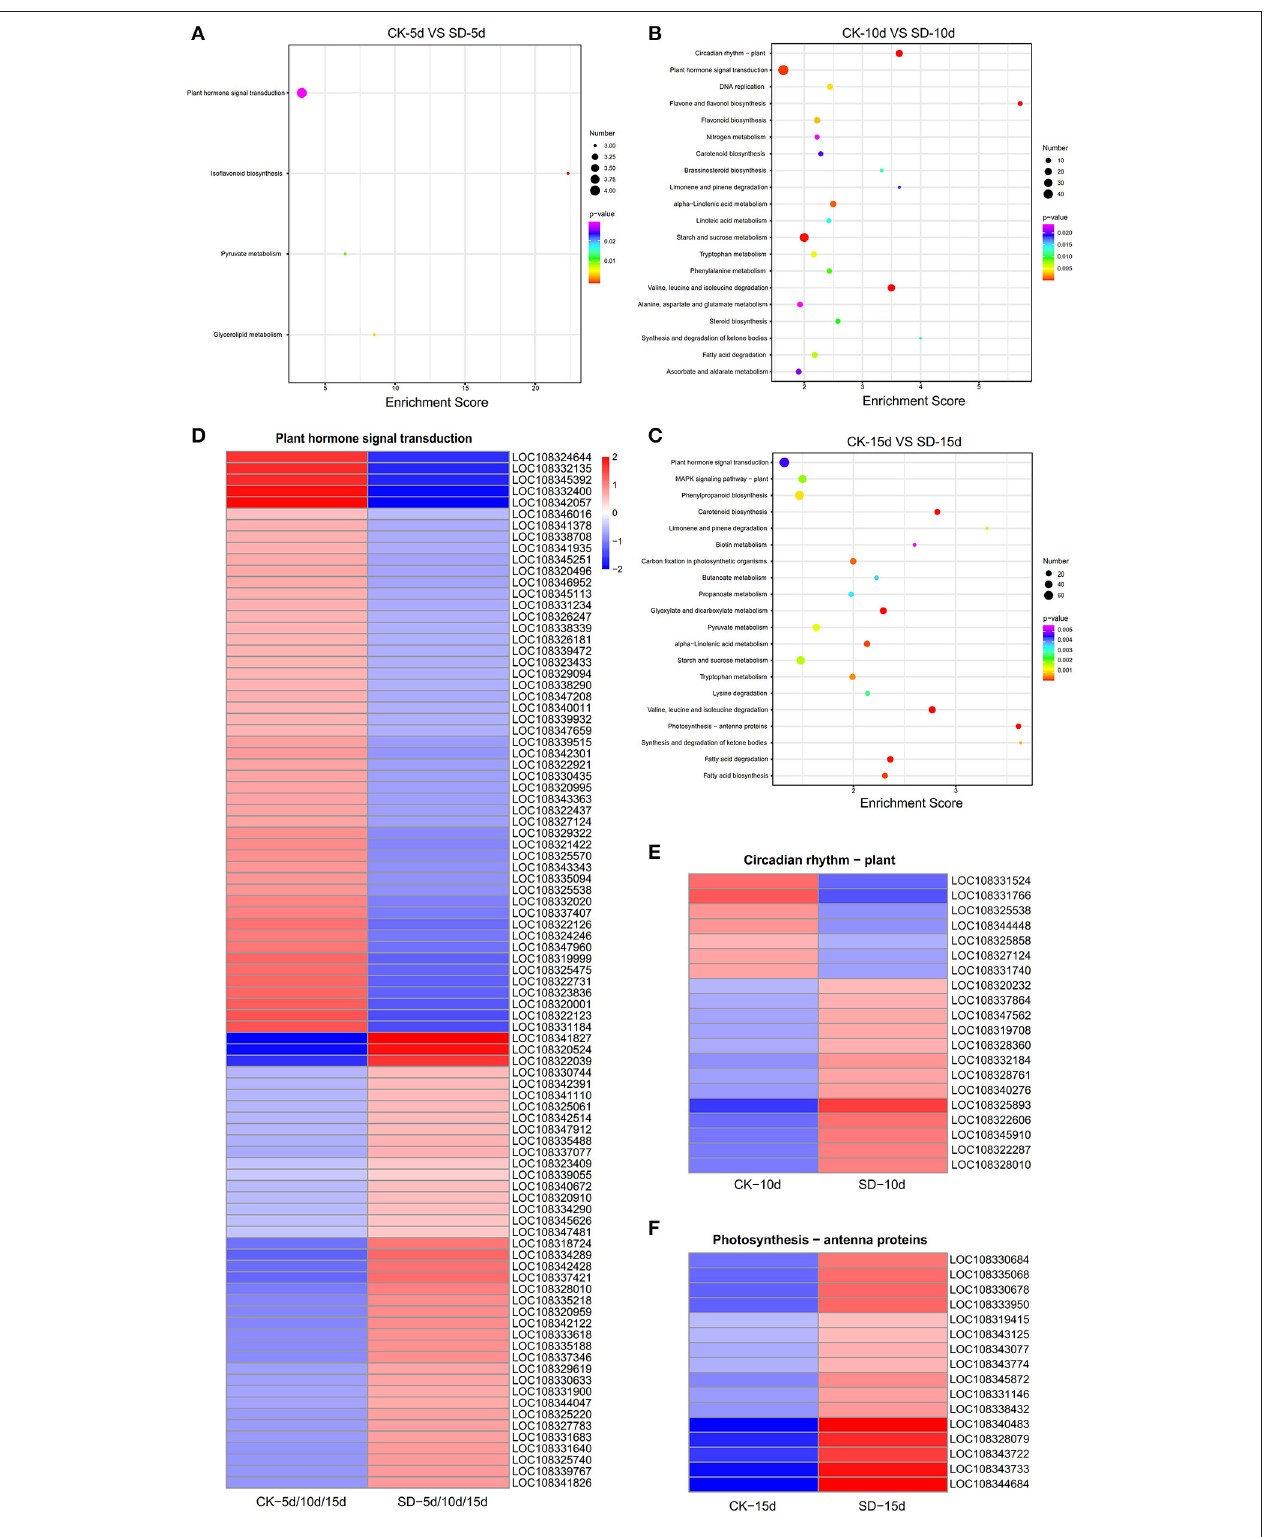
FIGURE 4 | Heat map clustering analysis of KEGG enrichment results of metabolic pathways in the three comparison groups. (A – C) KEGG enrichment results of metabolic pathways in CK-5d vs. SD-5d, CK-10d vs. SD-10d, CK-15d vs. SD-15d. Notes: the bubble size represents the number of genes that contain the difference. The number of differentially expressed genes in the pathway with large bubbles was larger. The color of the bubbles represents the degree of enrichment,